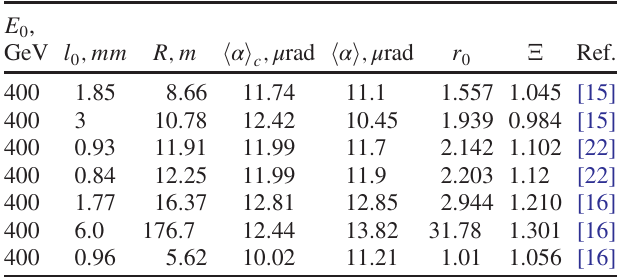
TABLE II. Experimental data for the mean volume reflection angle for (111) plane in bent silicon crystals. Here h α i c and h α i are the calculated and measured values of the volume reflection angle at E 0 ¼ 400 GeV.